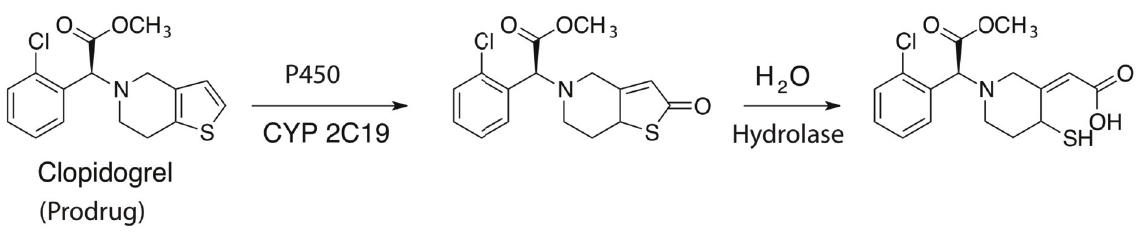
Figure 1. P450-mediated biotransformations of the prodrug clopidogrel